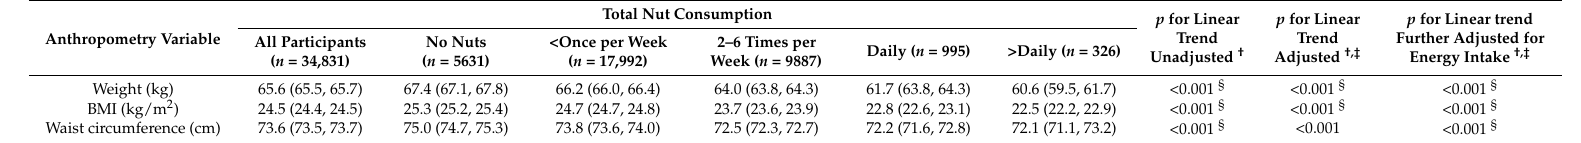
Table 3. Anthropometric measures by nut consumption category.